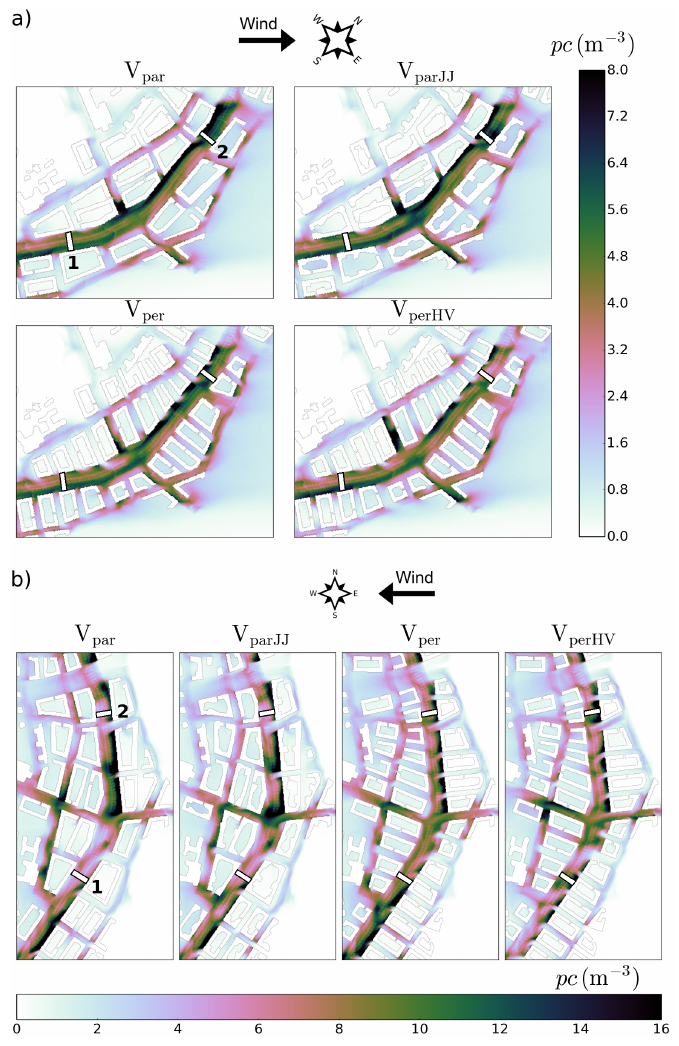
Figure 8. 40-min temporal mean of particle concentration pc (m − 3 ) at height z = 4 m under the ( a ) general and ( b ) wintry inflow conditions. Notice the orientation of the mean wind and different scales of pc . Cross sections in Figure 8 are marked with white